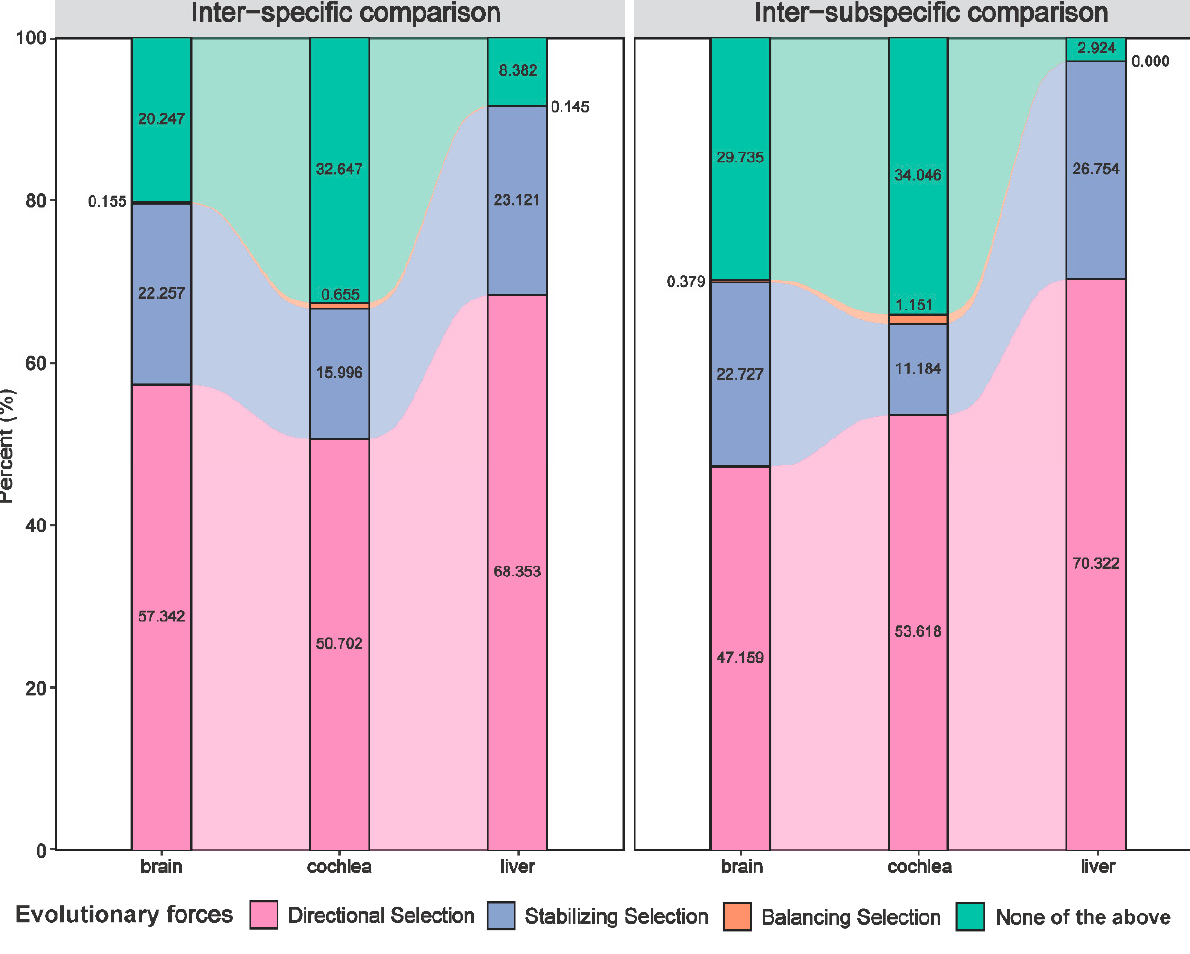
Figure 2. The ratio of differentially expressed genes (DEGs) whose expression likely evolved under natural selection, including directional selection, stabilizing selection, and balancing selection, in the inter-specific and inter-subspecific comparisons for three organs.